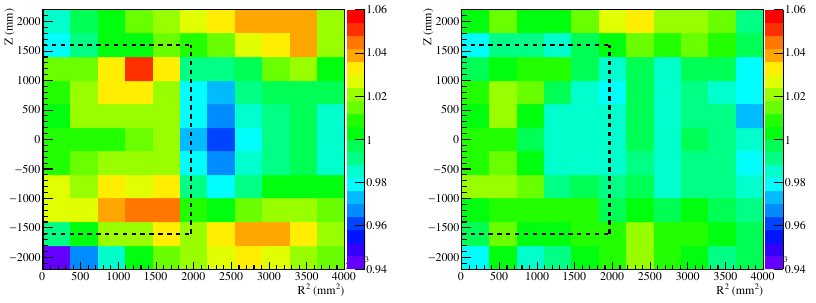
Figure 5 . Charge uniformity maps seen with n-H delayed energy peaks before (left panel) and after (right panel) spatial correction. The color code represents the fractional charge normalized to a reference value in a pixel. The radial coordinate R is de(cid:12)ned by represents a target